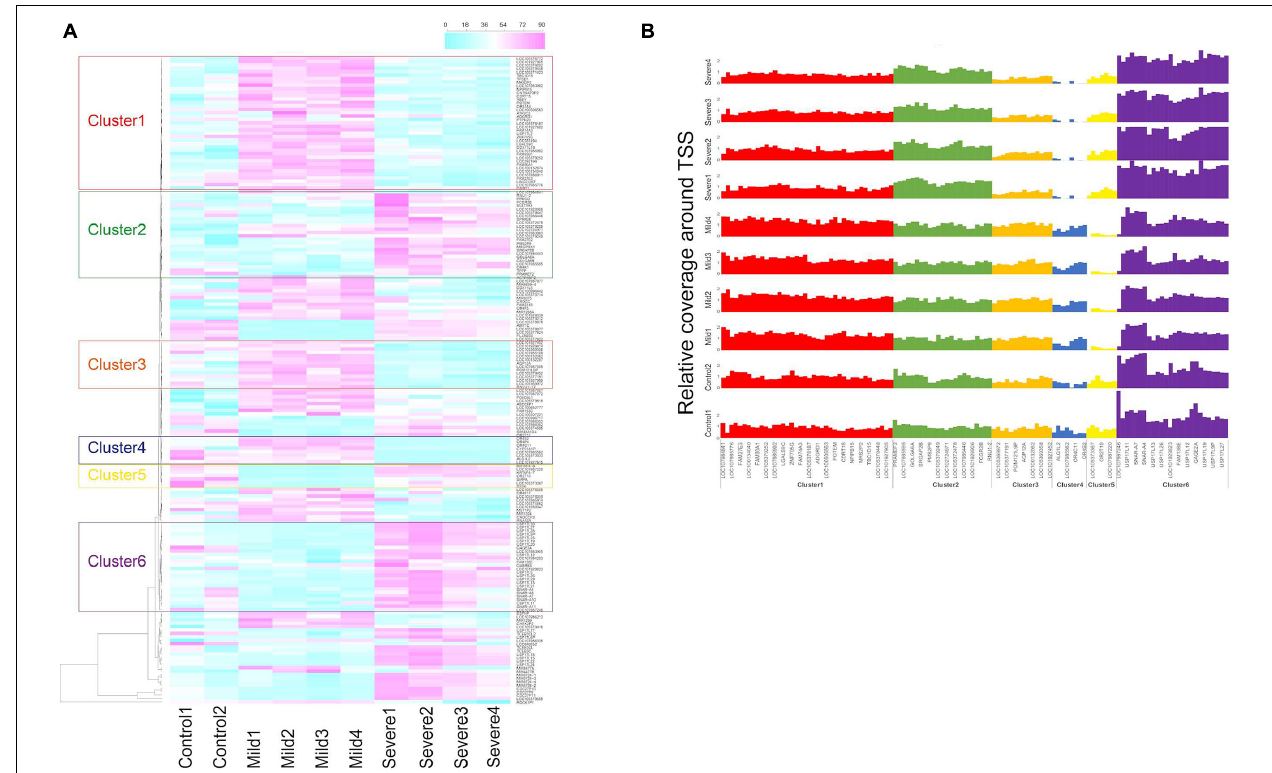
FIGURE 1 | Gene clustering based on transcriptional start site (TSS) coverage in controls, mild, and severe coronavirus disease 2019 (COVID-19) cases. (A) Gene clustering based on relative TSS depth in plasma samples of two control individuals and COVID-19 cases collected at hospitalization days 11 (Mild1), 17 (Mild2), 19 (Mild3), and 22 (Mild4) for mild case and days 16 (Severe1), 19 (Severe2), 25 (Severe3), and 29 (Severe4) for severe case. Color scale represents average coverage around TSSs of each gene weighted by average whole-genome sequencing depth from plasma cell-free DNA (cfDNA). (B) Relative coverage around TSS of genes from the six identified clusters in control, mild, and severe